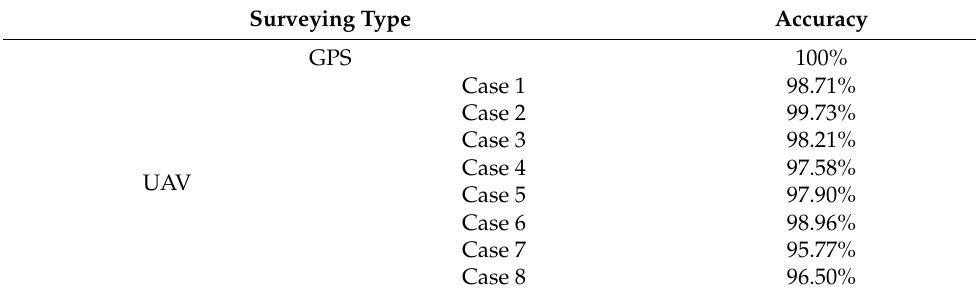
Table 8. Comparison of earthwork volume accuracy values (reference: GPS surveying).